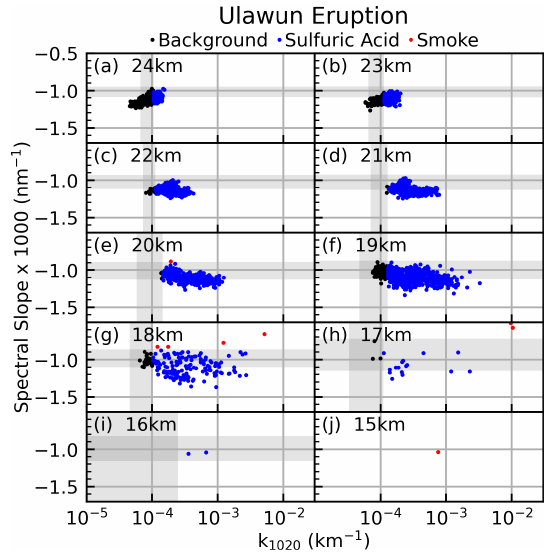
Figure 4. Spectral slope ( × 1000) as a function of k 1020 and altitude for data collected after the Ambae eruption and within the Ambae latitude band. The gray-shaded regions indicate the width of MAD ∗ as described in Eq. (3).